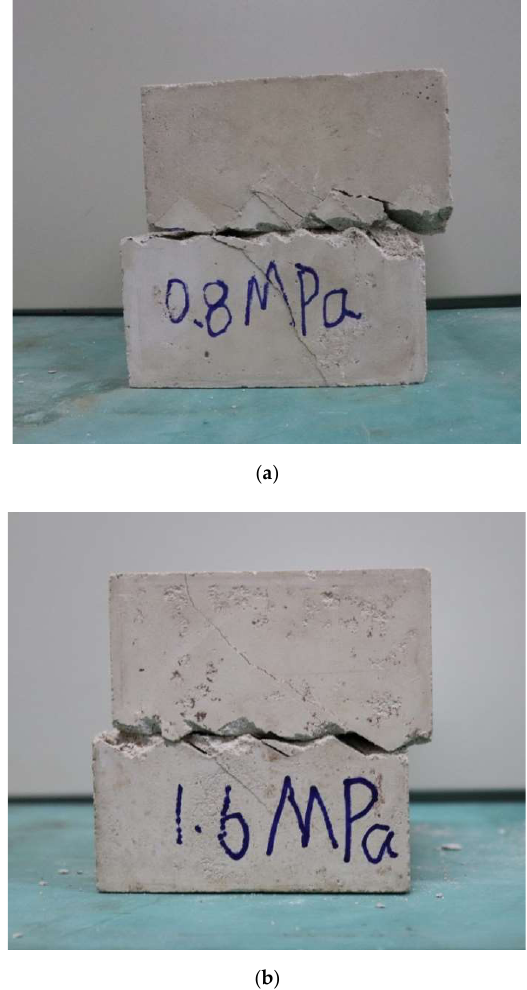
Figure 11. Tensile fracture mechanism. ( a ) Tensile crack of 45° sawtooth angle under 0.8 MPa normal stress. ( b ) Tensile crack of 30° sawtooth angle under 1.6 MPa normal stress.